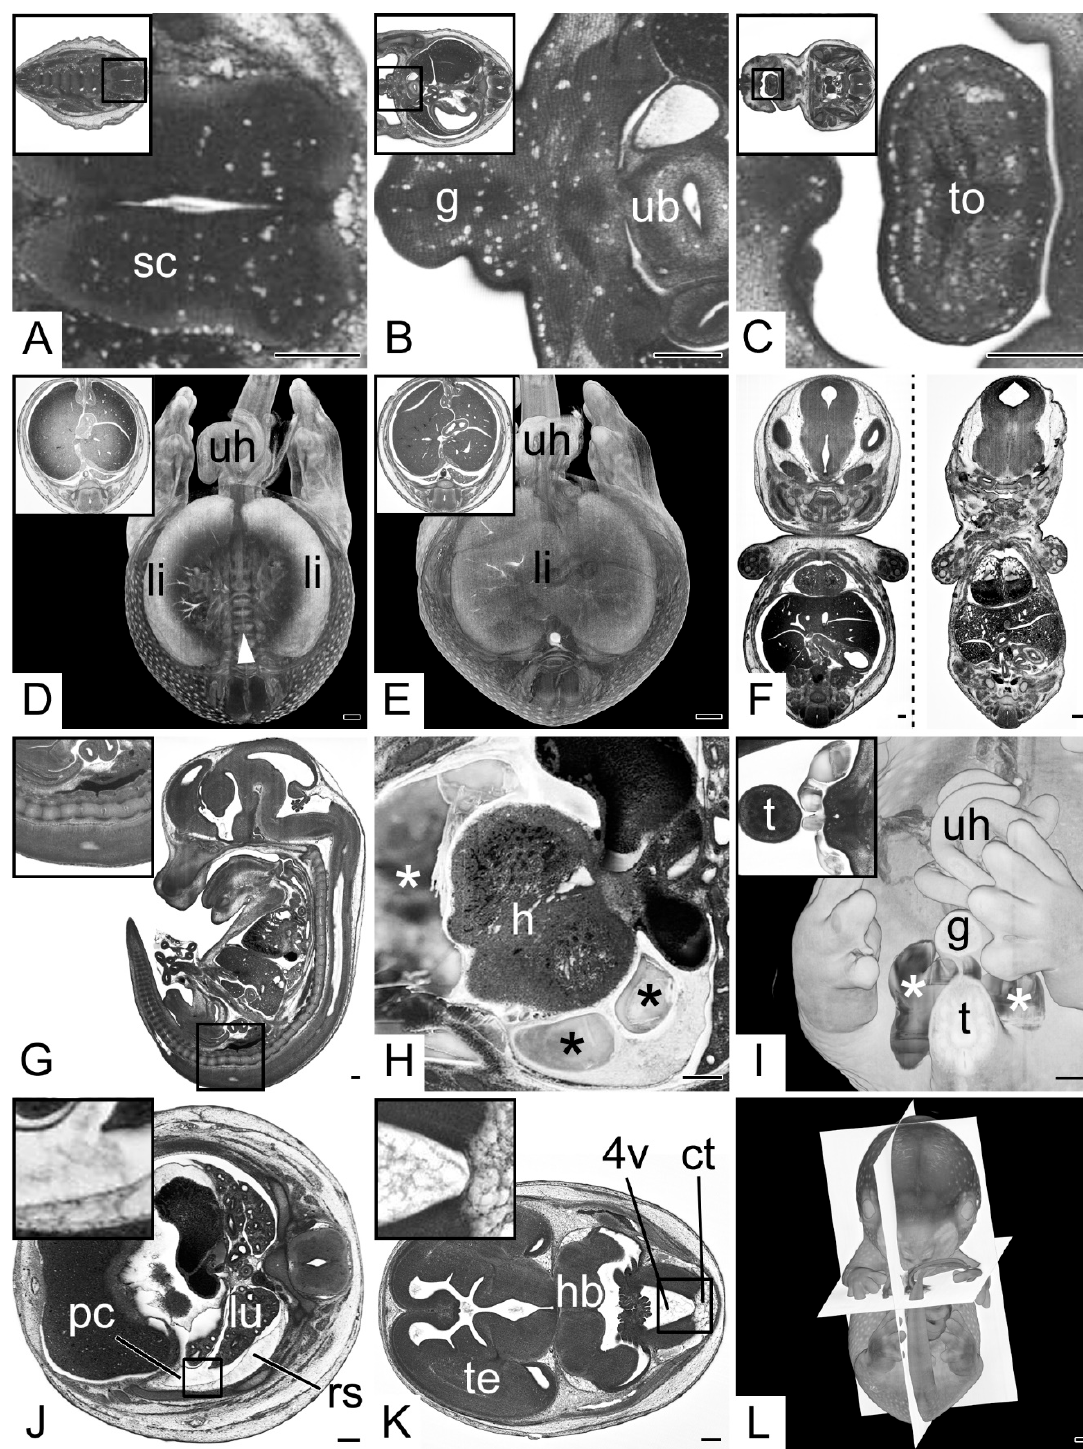
Figure 3. Specimen processing and embedding artefacts. ( A – C ) Vacuoles in various tissues. Transverse HREM sections, ventral to the left. Inlays: overview. ( A ) Caudal segment of spinal cord (sc). ( B ) Genital region (g). ( C ) Tongue (to). Note the vacuoles following the tissue border between mucosa and muscle tissue. ( D , E ) Low tissue contrast inside liver (li). Semitransparent volume model transected at the height of the umbilical hernia (uh). Inlays: Transverse HREM sections. ( D ) Due to the low contrast of the liver, its center is not rendered and the underlying vertebral column (white arrow head) is visible. ( E ) control. ( F ) Lateral deformation, coronal resections. Deformed embryo on the right showing lateral compression and flattening. Control on the left. ( G ) “Pseudolordosis” of the sacral spine, sagittal resection, ventral to the left. ( H , I ) Cavities (*) in resin block ( H ) Cavities (*) inside the pericardial sac near the heart (h). Transverse HREM section, ventral to the left. ( I ) Cavities (*) outside the embryo body, near the base of the tail (t). A 3D model from ventral. Inlay: